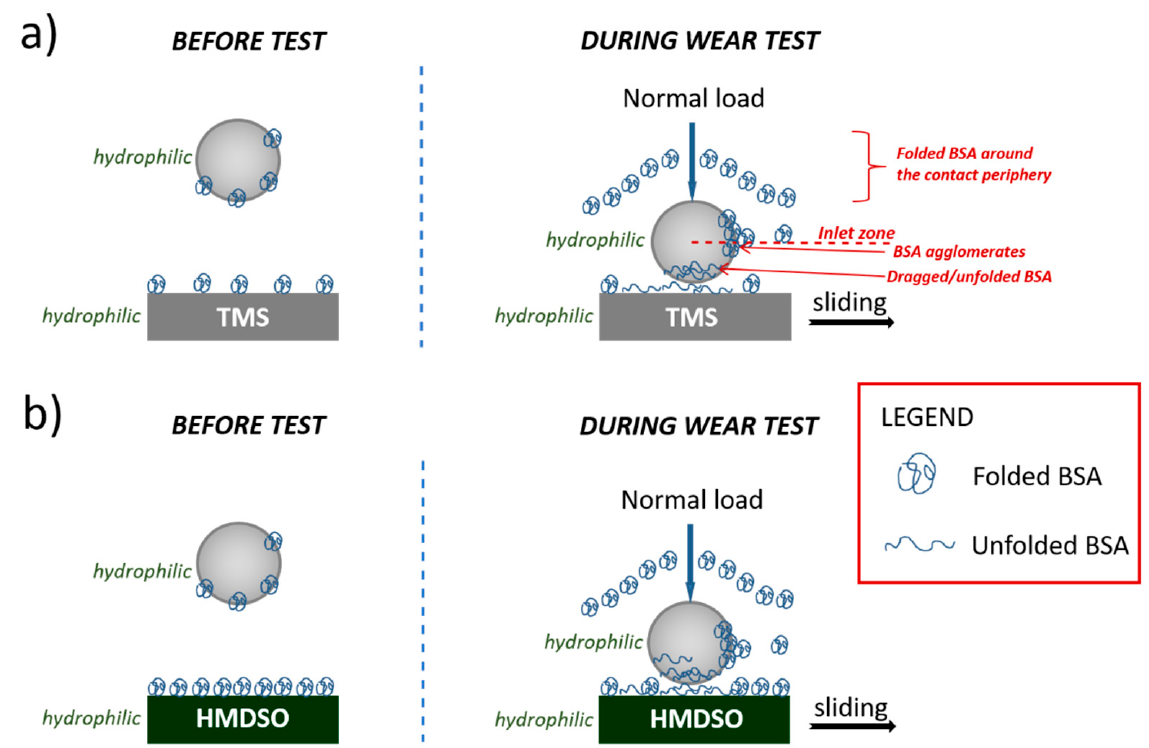
Figure 9. Model of interaction between BSA and silicon-incorporated DLC films synthesized using ( a ) TMS and ( b ) HDMSO.